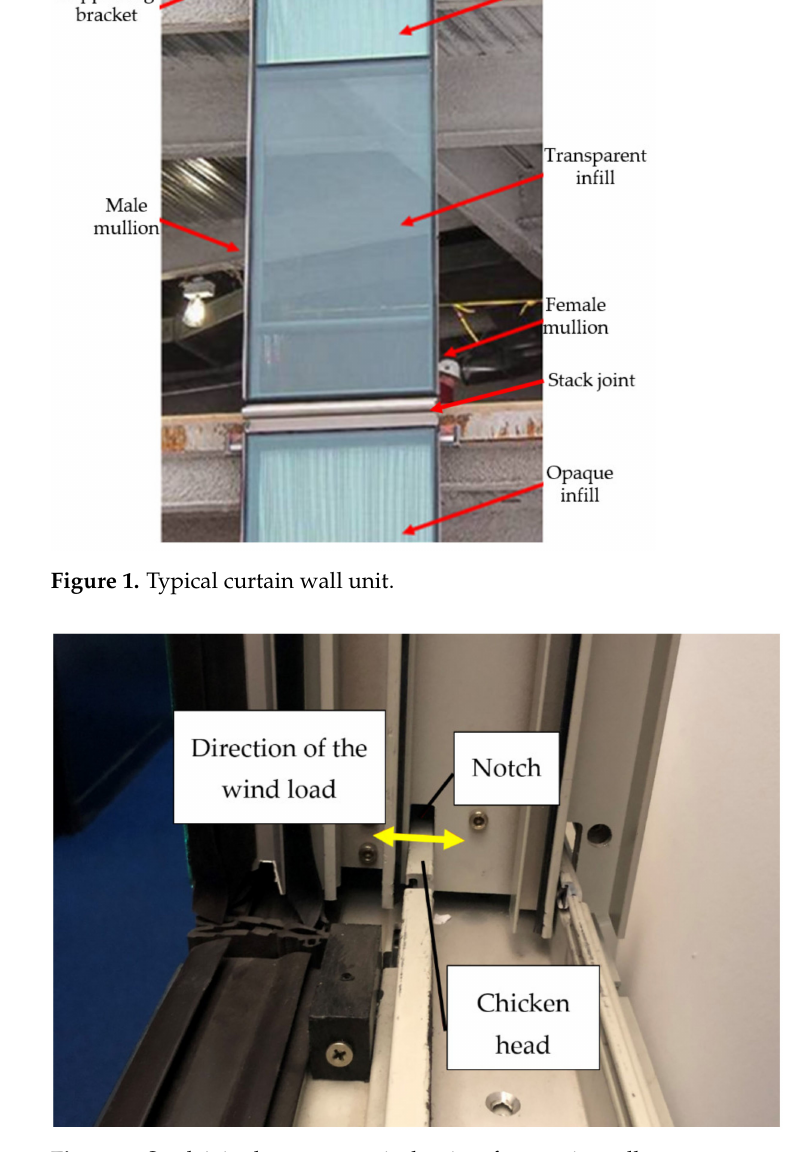
Figure 2. Stack joint between vertical units of a curtain